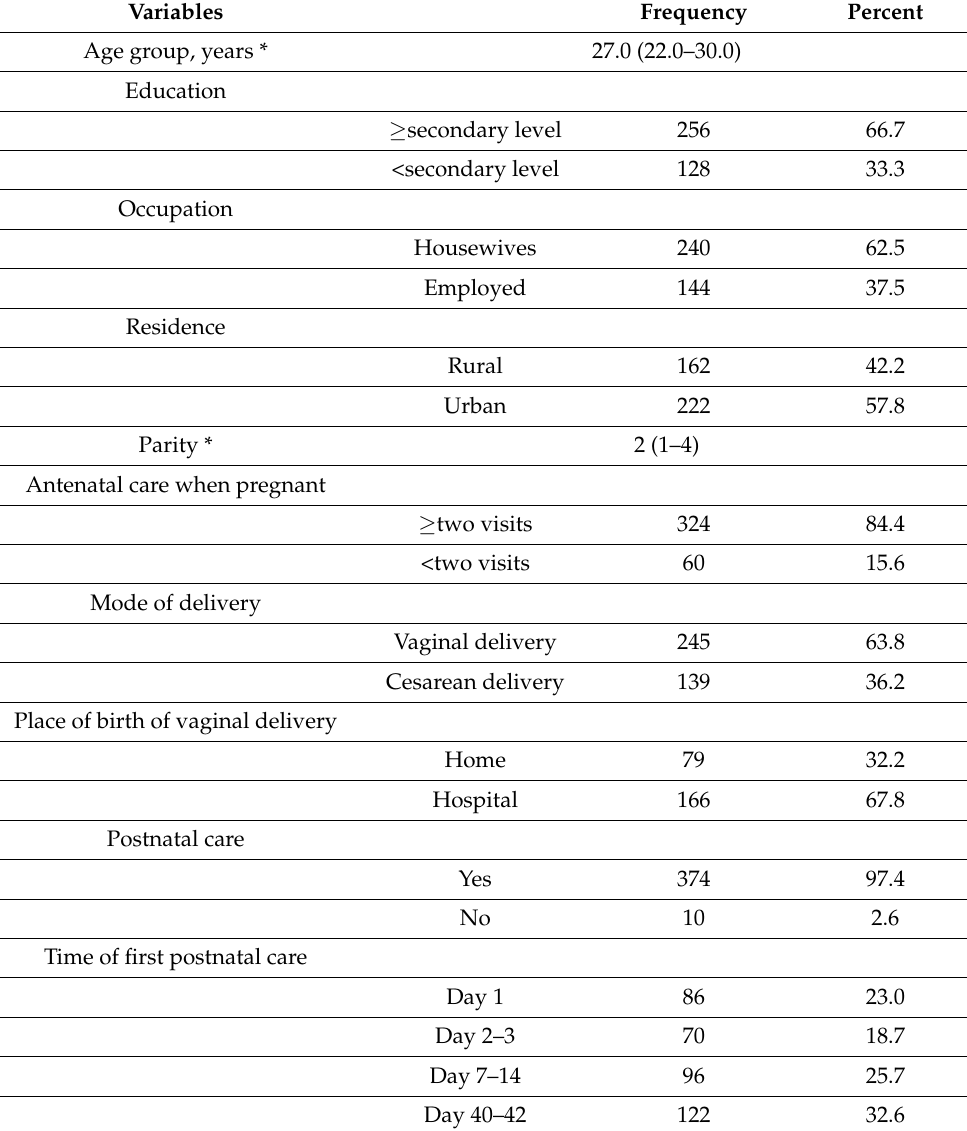
Table 1. Sociodemographic characteristics of the study population.